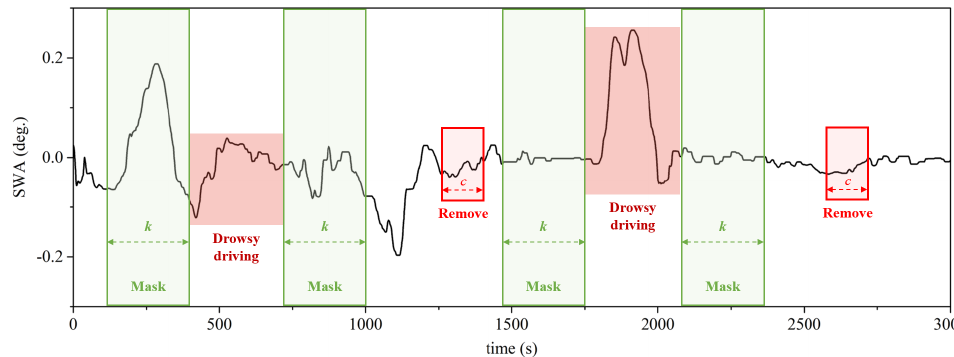
Figure 4. Mask and removal data selected by the proposed imbalanced data-handling